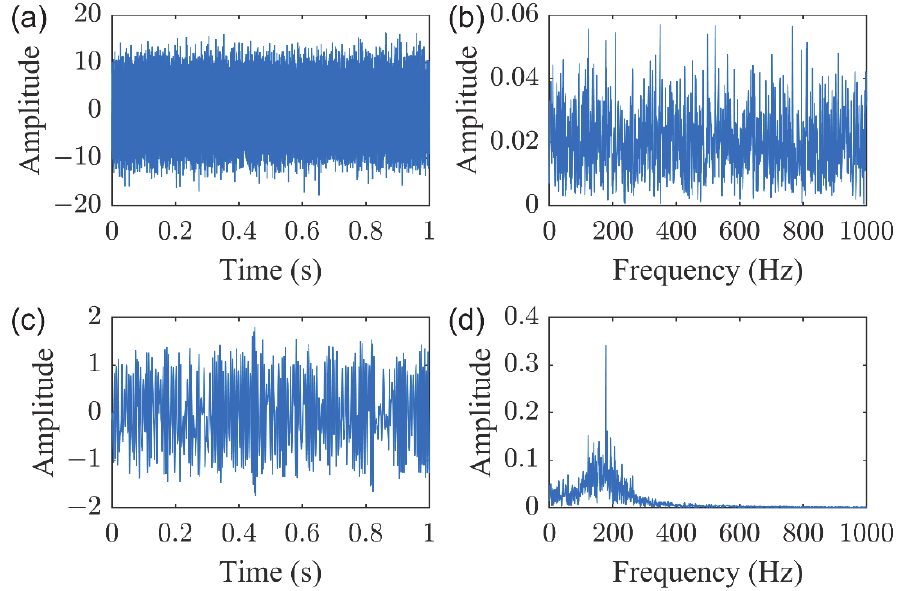
Figure 6. Analyzed results of the noisy signal: ( a ) waveform of the noisy signal; ( b ) spectrum of the noisy signal; ( c ) waveform of the TFAI-EO-ASR output; ( d ) spectrum of the TFAI-EO-ASR output.